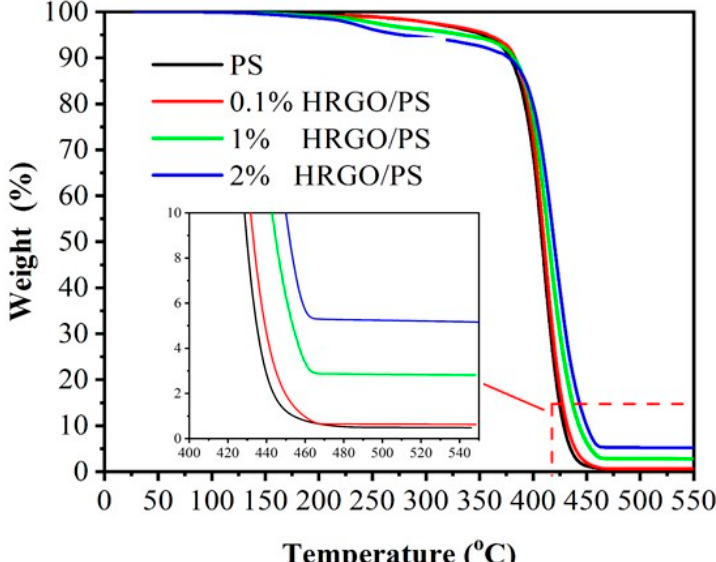
Figure 4. Thermogravimetric analysis (TGA) curves of 0.1% HRGO/PS, 1% HRGO/PS, and 2% HRGO/PS nanocomposites.